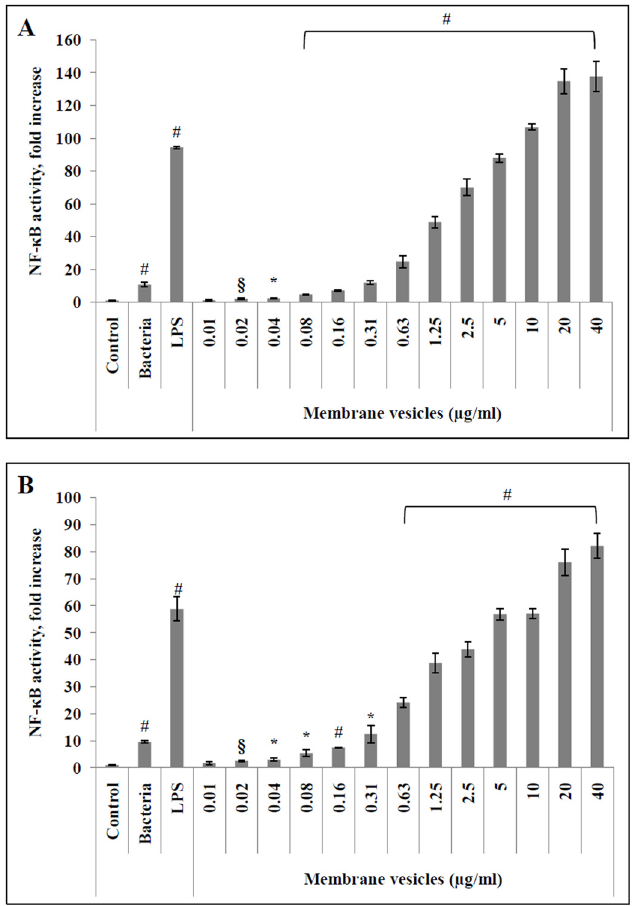
Fig 5. Quantification of NF- κ B activation in U937-3x κ B-LUC monocytes (A) and macrophage-like cells (B) by S. suis membrane vesicles (0.01 to 40 μ g/ml), E. coli LPS (10 μ g/ml), and S. suis P1/7 whole bacteria (MOI = 100). Results were considered significant at §: p < 0.05, * : p < 0.01, and #: p < 0.001 compared to unstimulated